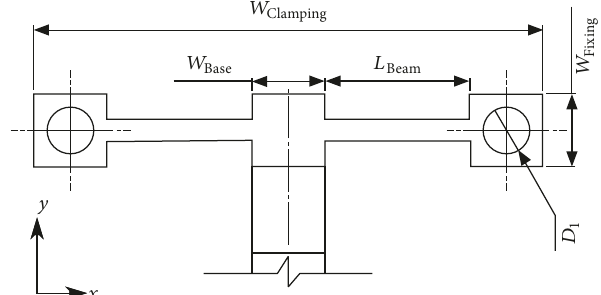
Figure 2: Scheme of the harvester